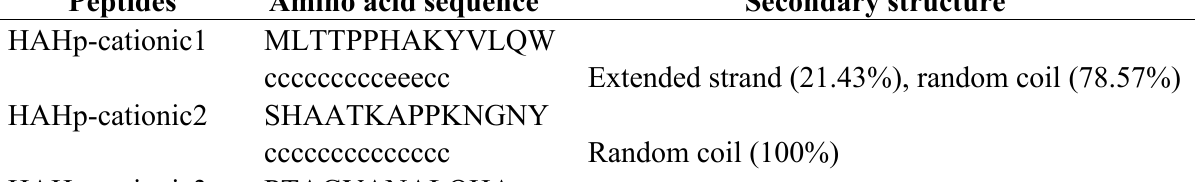
Table 2. Secondary structure prediction of charged peptides in HAHp2-3-I.